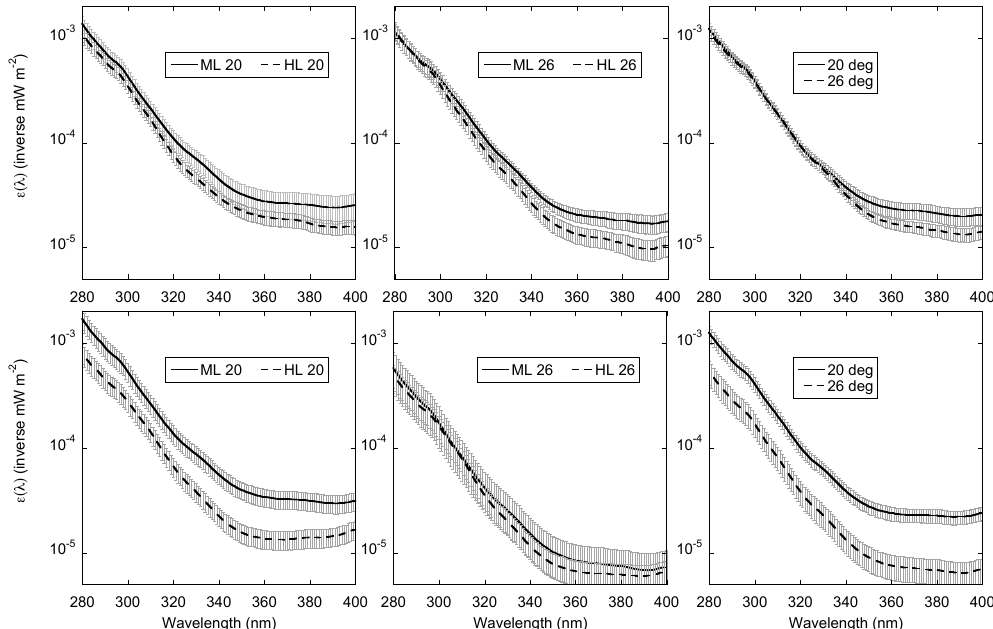
Figure 6. Average ( ± standard error) of biological weighting functions for WH8102 (upper three panels) and WH7803 (lower three panels) grown in either “medium” irradiance (ML, 77µmolm − 2 s − 1 PAR) or “high” irradiance (HL, 174µmolm − 2 s − 1 PAR), and growth tempera- tures of 20 or 26 ◦ C. Weights were estimated for 265–400nm, but the weights for wavelengths below 280nm are not shown since coefficients in the 265–280nm range may be influenced by the edge artifact illustrated in Fig. 4.